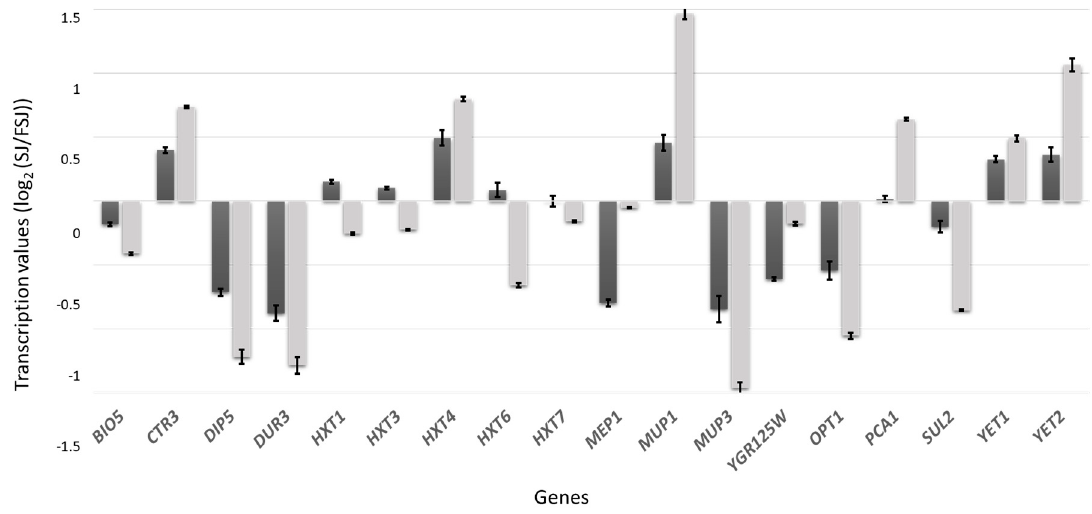
Figure 6. Transcription values of genes di ff erentially expressed in EC1118 (black bars) and M25 (gray bars) in the functional category GO:0005887 “integral component of plasma membrane”. Data are mean log2 ratio (SJ / FSJ) ± standard deviation of three independent biological replicates.